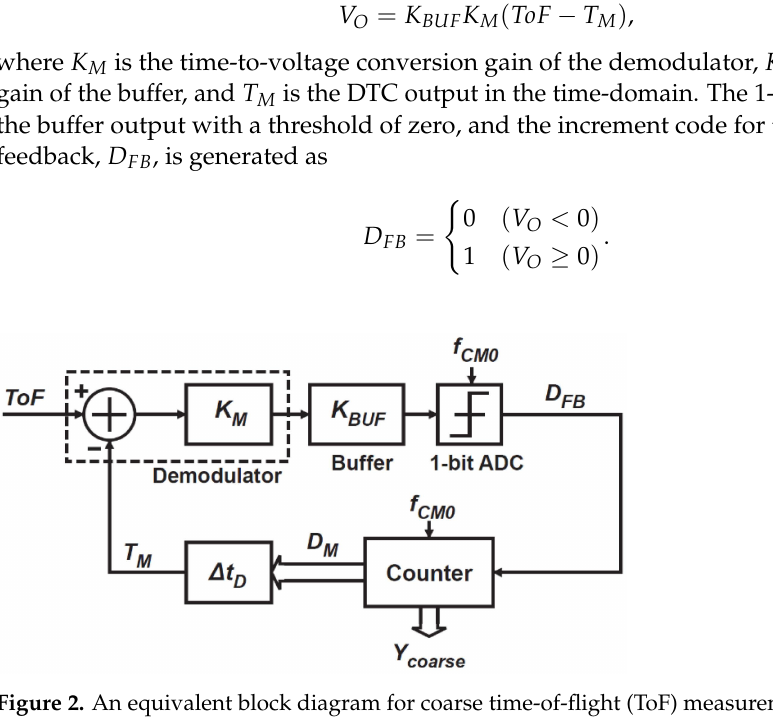
Figure 2. An equivalent block diagram for coarse time-of-flight (ToF)